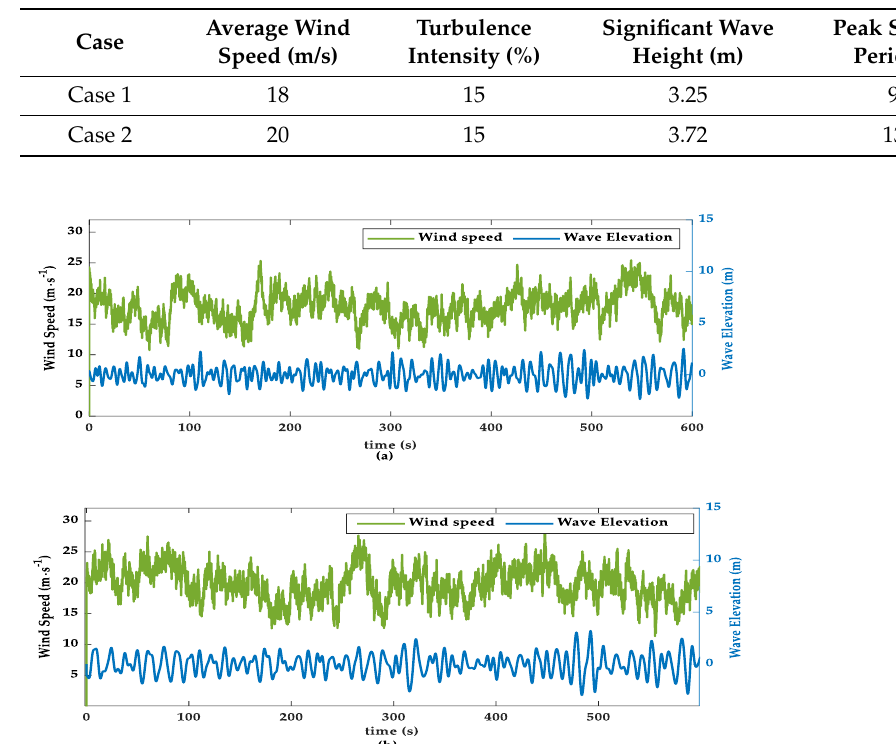
Figure 3. ( a ) Wind speed and waves for Case 1, and ( b ) wind speed and waves for Case